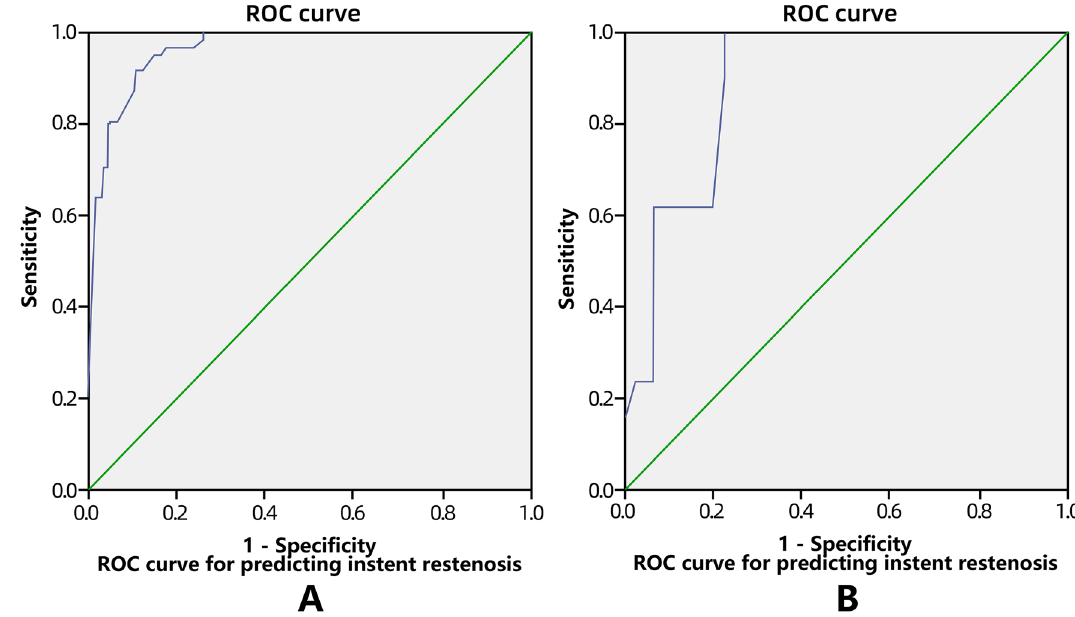
Figure 5. Receiver operating characteristic (ROC) curve for predicting instent restenosis based on imaging and clinical features in the modelling ( A ) and validation ( B ) group.